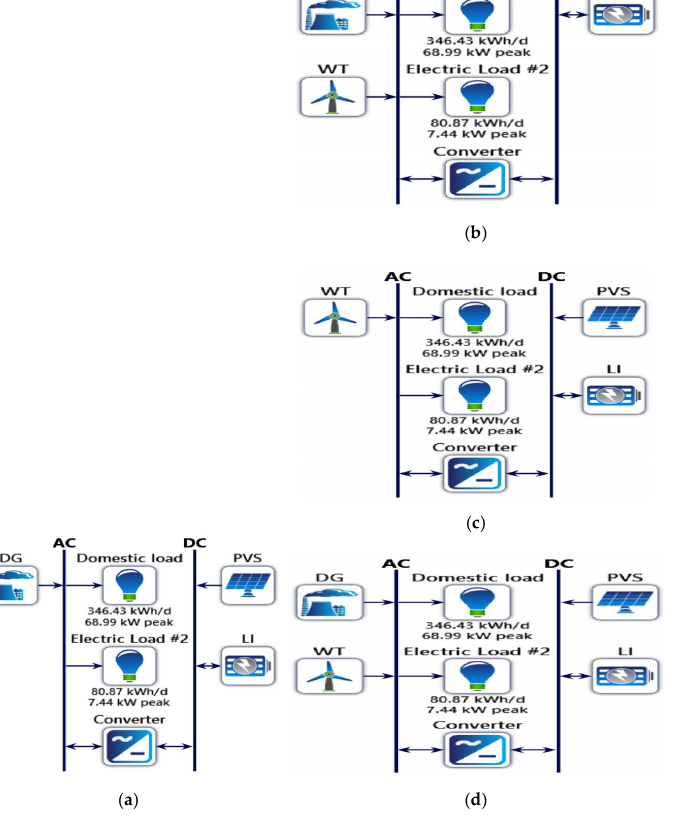
Figure 4. Schematic diagram of hybrid system ( a ) PVS/DG; ( b ) WT/DG; ( c ) PVS/WT; ( d ) Schematic diagram of hybrid system ( a ) PVS/DG; ( b ) WT/DG; ( c ) PVS/WT; PVS/WT/DG. ( d )